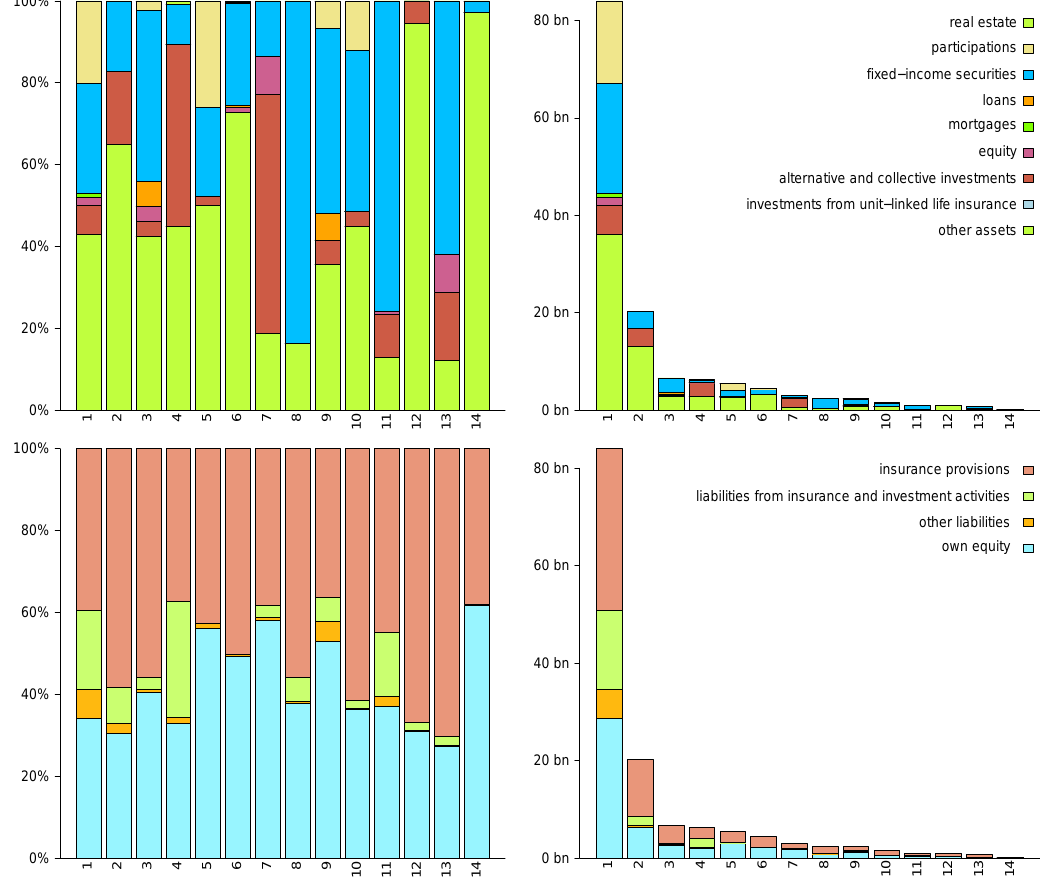
Figure A5. Reinsurers’ assets ( top ) and liabilities ( bottom ) as used for the case study. Values on (lhs) are relative and in percentage, values on (rhs) are absolute and in billion